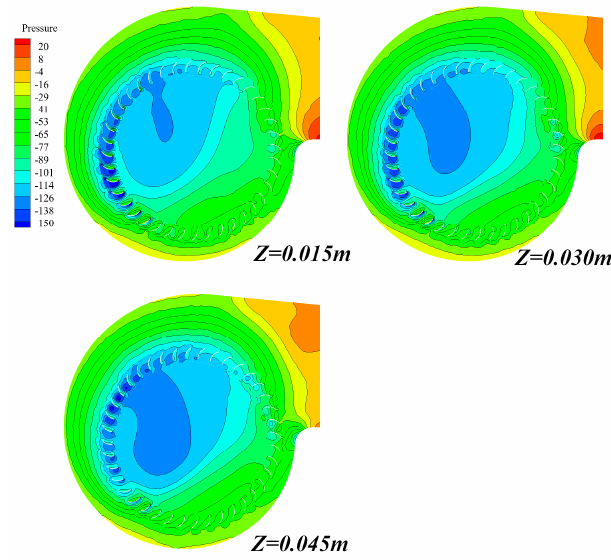
Figure 8. Static pressure of cross-sections at different positions (Q/Qn = 0.031).